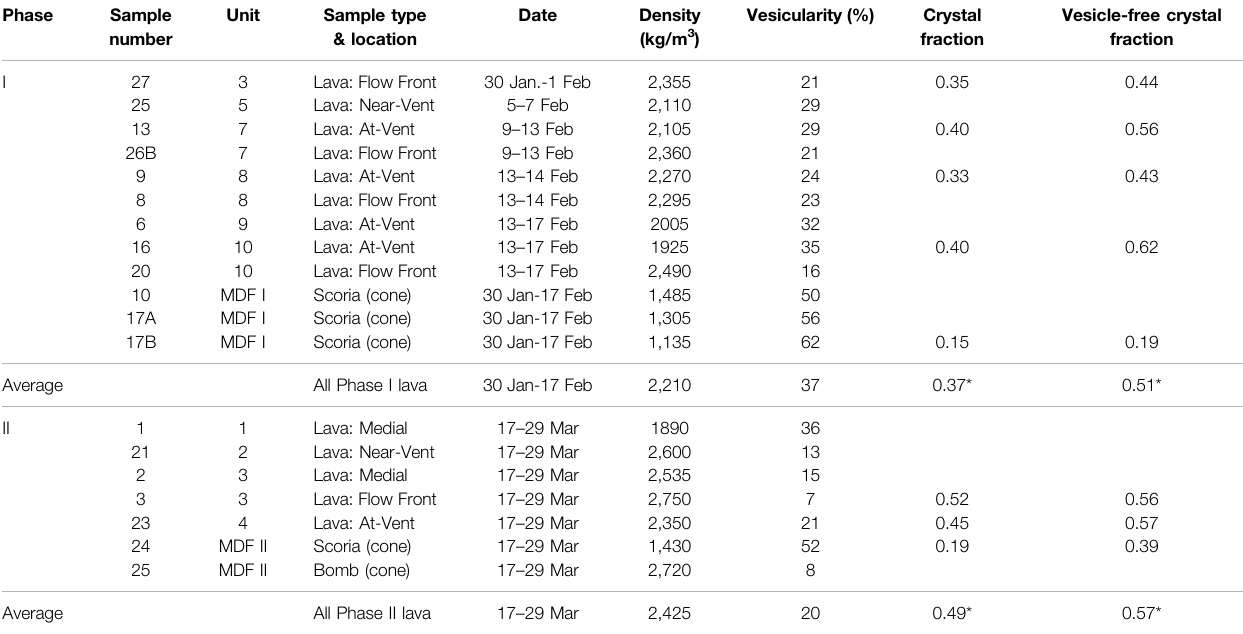
TABLE3| Densities, vesicularitiesandcrystallinitiesbyphaseandunit.DatesassignedtoemplacementofeachunitarefollowingthechronologygiveninGuestetal.(1974). Phase Sample